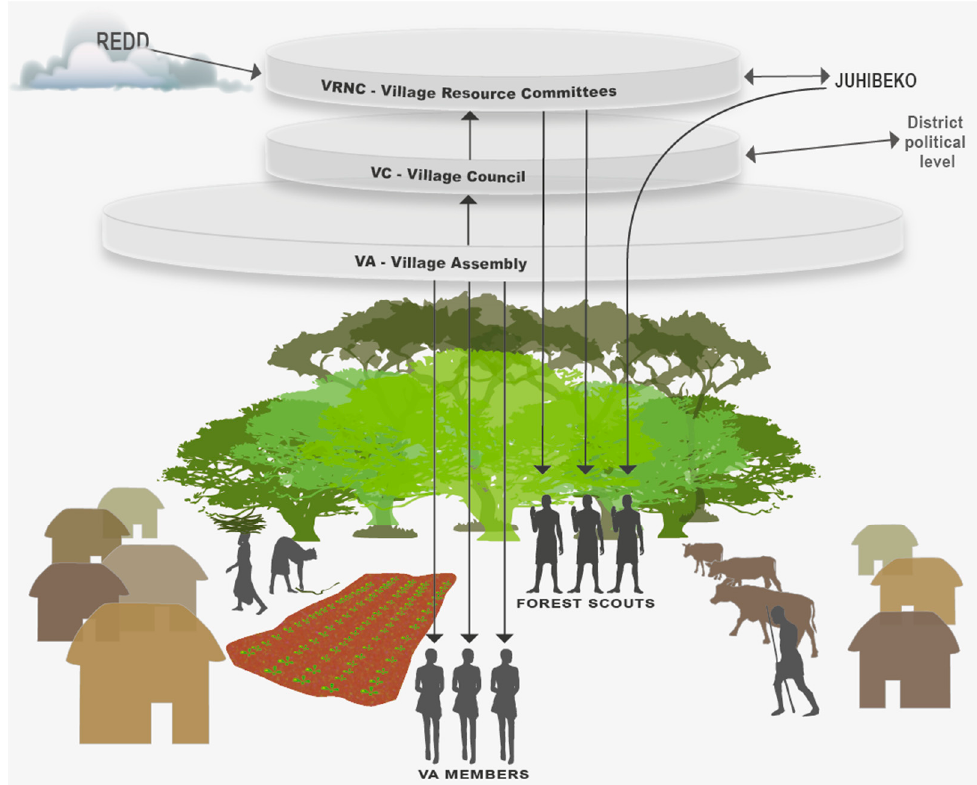
Figure 1. The political decision bodies of the Kolo Hills villages. The figure visualizes the complex institutional structure at village level of the studied REDD+ project (the ARKFor project). The figure is focused on how the individuals in a household in a village perceive the institutional structure. The household members regarded the nearby forest mainly as a resource for firewood, medicinal plants, and building material. Sometimes the forest was also used as a grazing area for cattle and/or sheep. For some (often poor households lacking agricultural land), it was also a resource base for collecting firewood and producing charcoal to sell at a market. As the REDD project was being implemented, these activities were banned, and villagers who nonetheless attempted to circumvent the regulation were often confronted by the forest scouts. The figure shows how the forest scouts are organized within the institutional structure. Each adult in the village also has (voluntary) contacts with the village assemble (VA), of which they are members, and can vote on their member in the village council. The village natural resource committees (VNRC) were introduced and organized by the AWF, so that the villagers would be able to administer the use of the forests. The members of the VNRCs were six to twelve elected individuals. An inter-village organization, Jumuhiya ya hifadhi yamazingira tarafa za Bereko na Kolo (JUHIBEKO), was also formed by the 13 villages that border the forest reserves Isabe and Salanga (15 villages border the forest reserves, but two declined to participate in the REDD+ project). Three VNRC members from each village are part of JUHIBECO’s council.